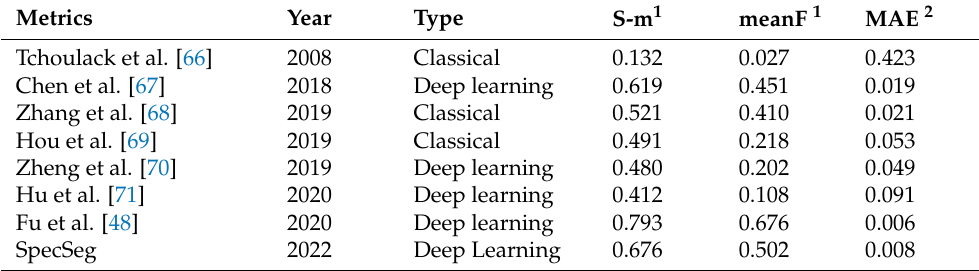
Figure 9. Specular segmentation results on outdoor images acquired on a sunny day and under clear sky conditions. Specular reflections detected under extreme conditions are plausible and significantly better than any other state-of-the-art technique. Note that brightly lit regions such as the sky or water puddles are not detected as specular regions. Table 4. Qualitative comparisonof SpecSeg network to classical and deep learning SOTA